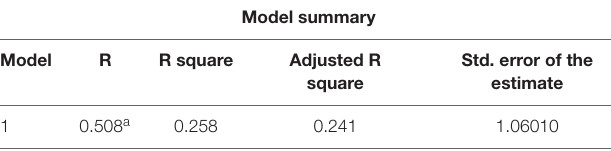
TABLE 6 | Multiple regression analysis for public school students.